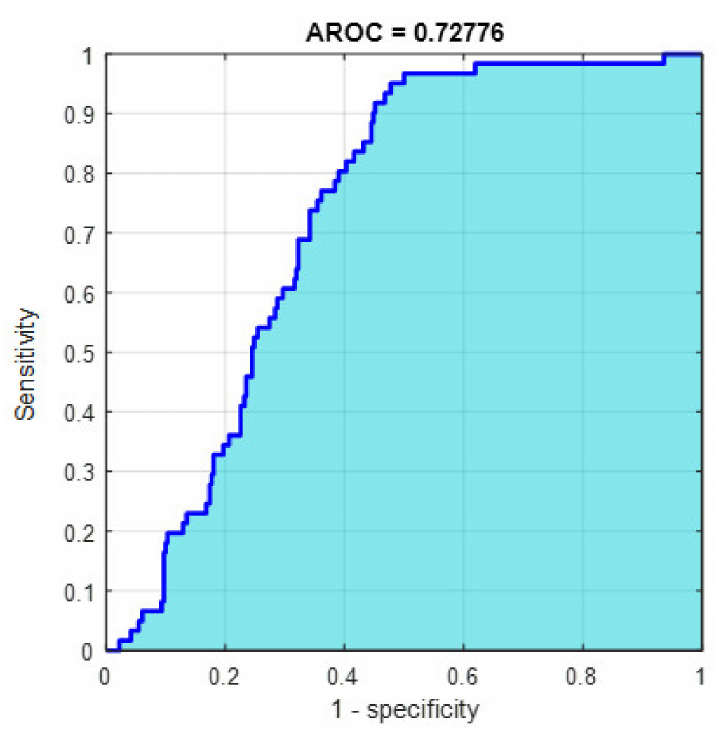
Figure 26. The AROC for type grading using 1000 deep learning